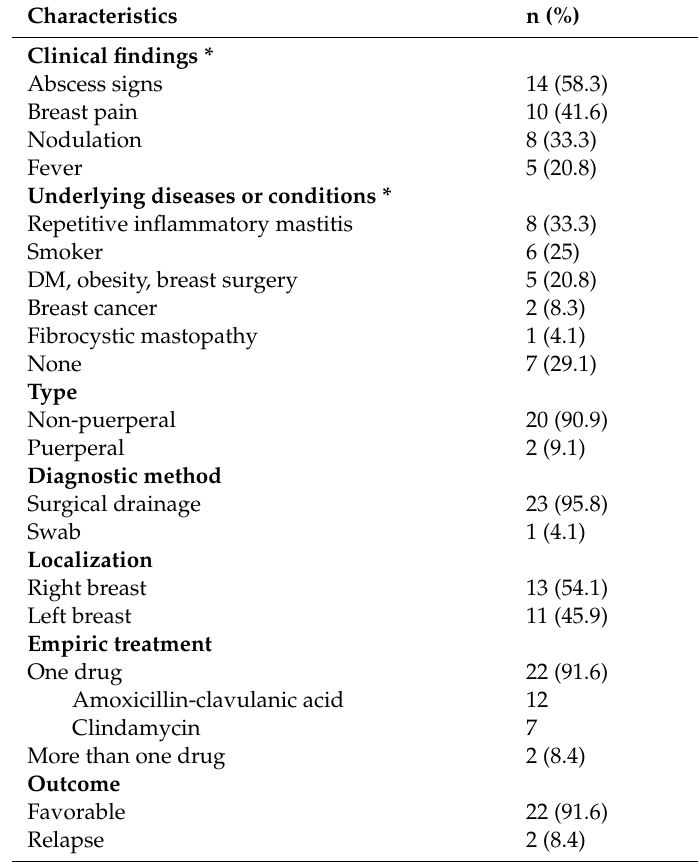
Table 1. Characteristics of 24 patients with breast abscesses caused by anaerobes.